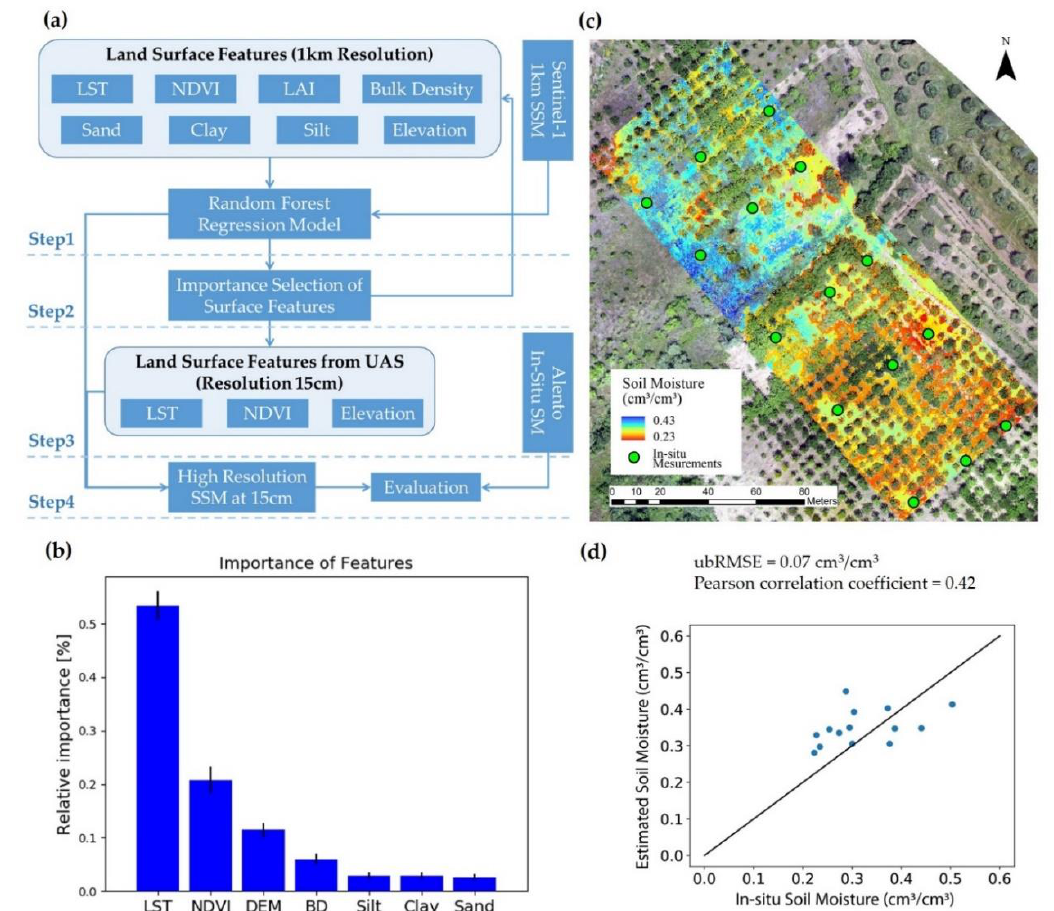
Figure 3. ( a ) Soil moisture downscaling workflow based on random forest regression (RF); ( b ) The importance of land surface features for the RF model; ( c ) RF-based downscaling of Sentinel-1 soil moisture products at 1 km to 15 cm, taking land surface features derived from UAS as predictors over the MFC2-Alento catchment. The UAS thermal image taken at sunrise 05:13 14 June 2019 was used to derive LST, the multispectral image taken 15:42, 13 June 2019 was used to derive NDVI; ( d ) the comparison of the downscaled soil moisture with in situ measurements.